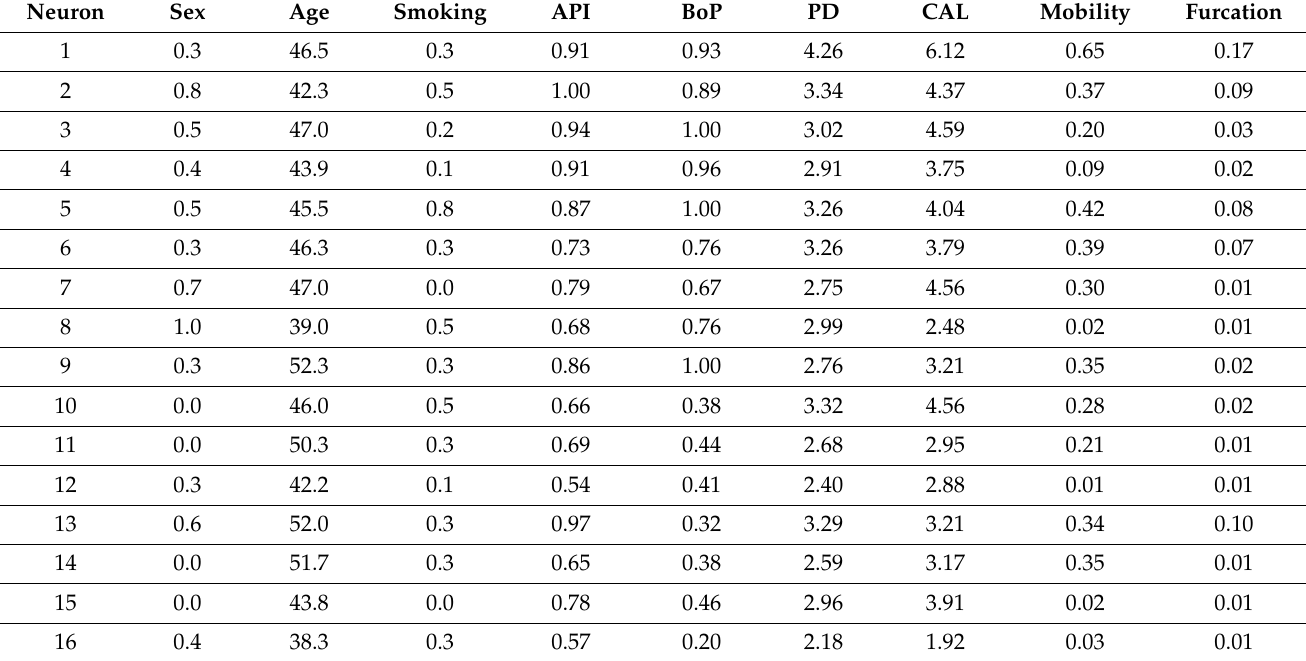
Table 2. Average values of the patient pattern corresponding to each neuron (N)